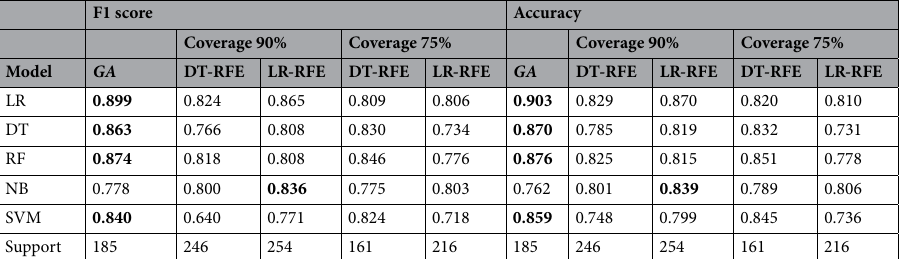
Table 3. Classification with leave-one-out cross validation on the first wave dataset. The bold font identifies the models with best performance, for each of the different rows (i.e. for each predictive model type). Each row corresponds to a different model type. We compare models trained on variables selected by our feature selection method (GA) with those selected by the two recursive feature elimination algorithms with the two different coverage thresholds (DT-RFE,